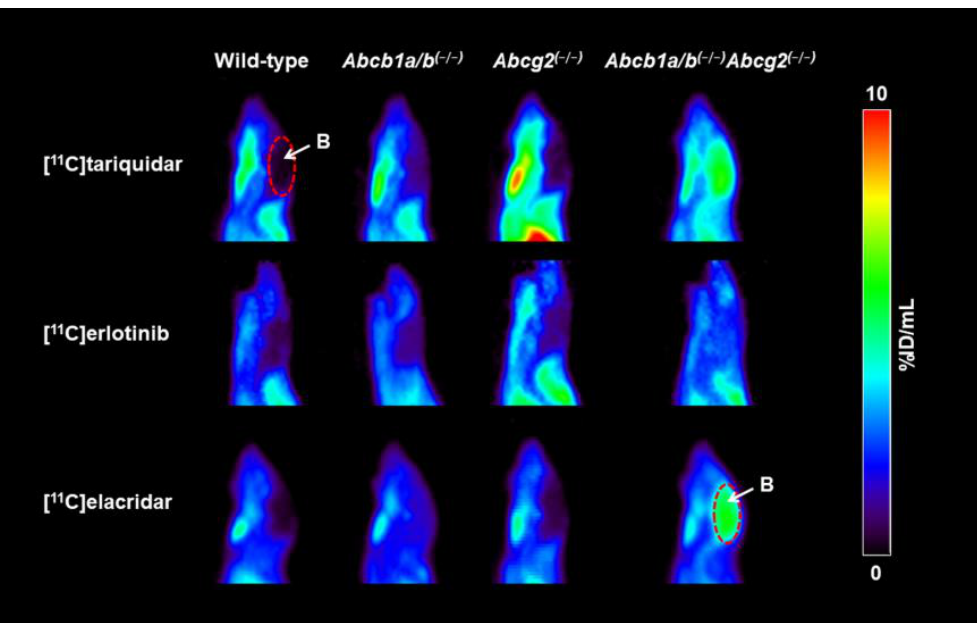
Figure 2. Sagittal PET summation images (0–60 min) of the head obtained after i.v. injection of either [ 11 C]tariquidar, [ 11 C]erlotinib, or [ 11 C]elacridar in one representative wild-type, Abcb1a/b ( − / − ) , Abcg2 ( − / − ) , and Abcb1a/b ( − / − ) Abcg2 ( − / − ) mouse. Radioactivity concentration is expressed as percent of injected dose per milliliter (%ID/mL). Brain (B) is labeled with white arrows and red dashed-line areas.